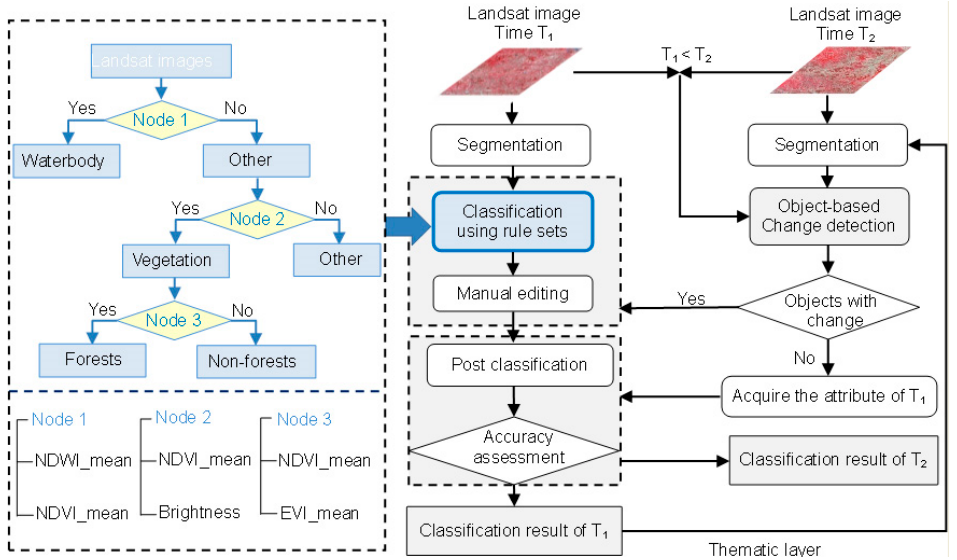
Figure 2. Flowchart of forest mapping using integrated updating and an object-based image analysis method.